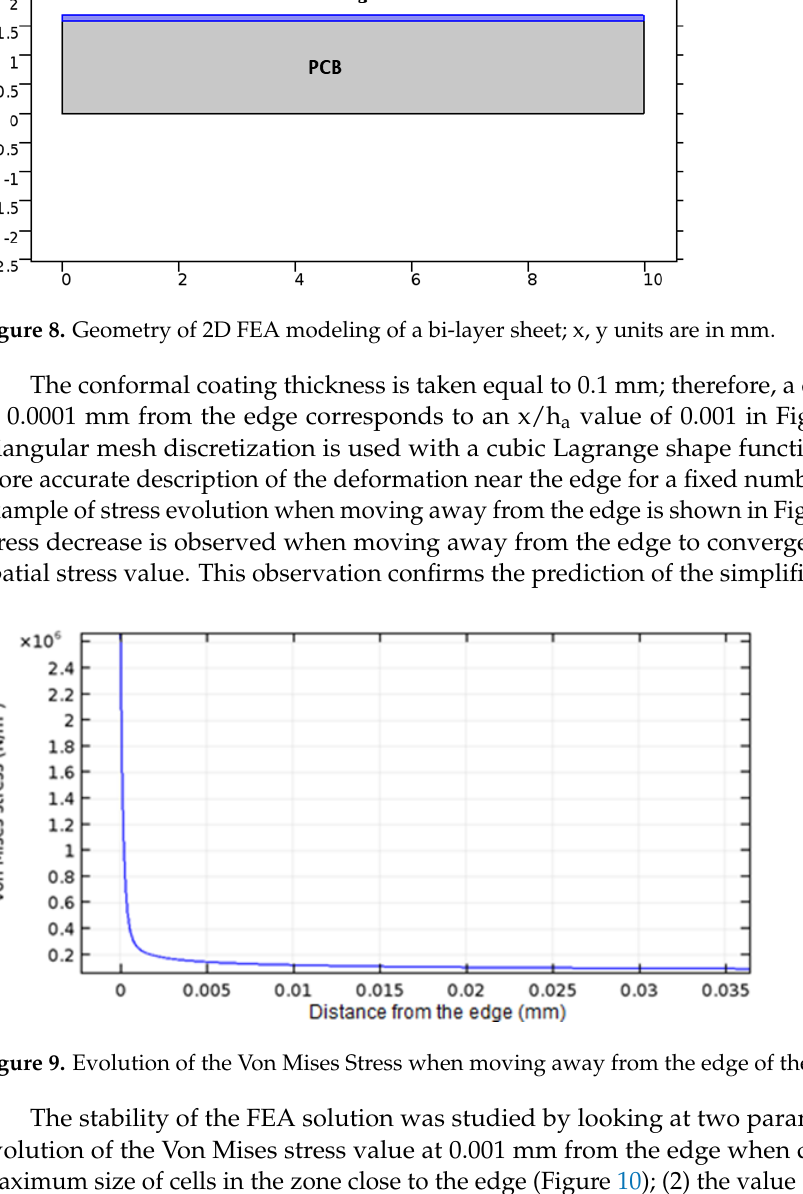
Figure 10. Von Mises stress evolution with the change of the maximum cell size in the domain close to the edge.